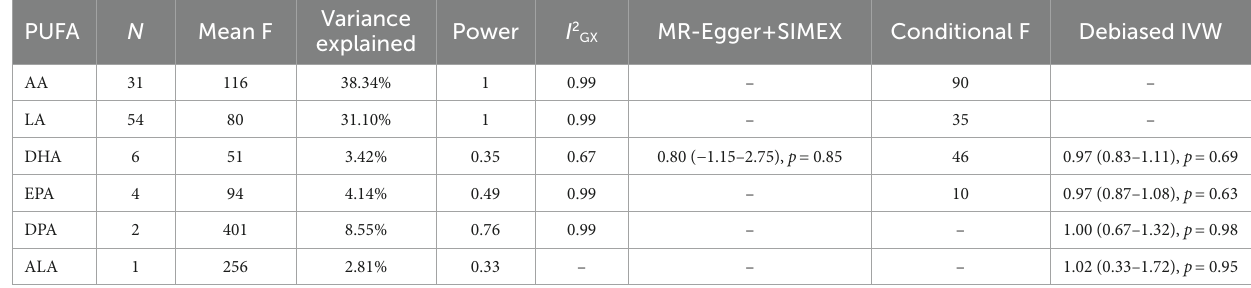
TABLE 1 Results of instrument strength assessment and debiased IVW.